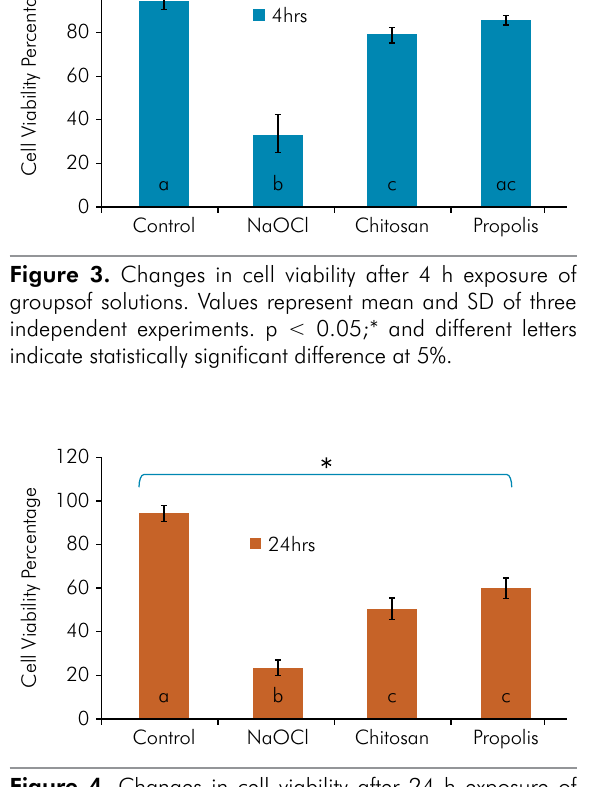
Figure 4. Changes in cell viability after 24 h exposure of groupsof solutions. Values represent mean and SD of three independent experiments. p < 0.05;* and different letters indicate statistically significant difference at